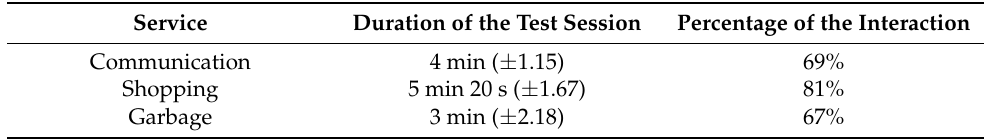
Table 1. Interaction percentage during the test sessions.